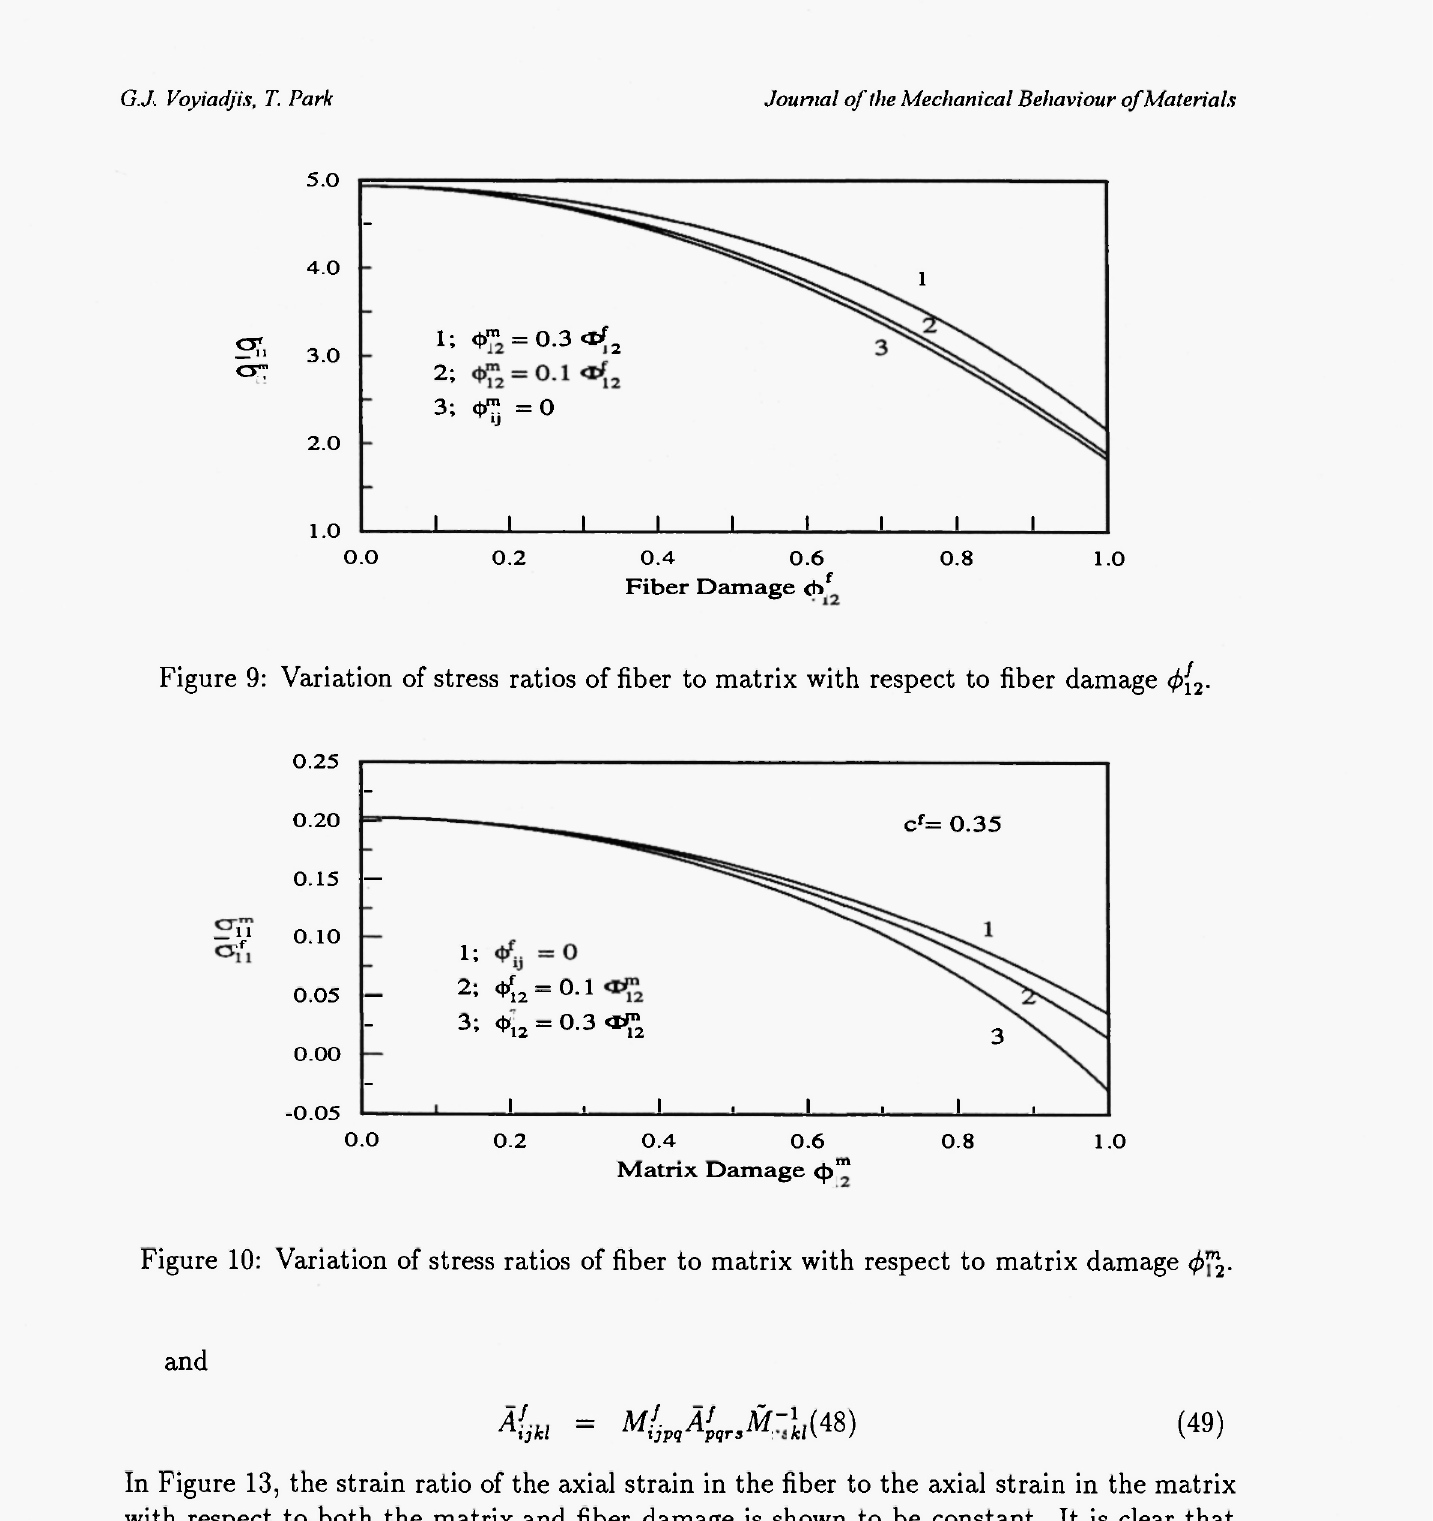
Figure 10: Variation of stress ratios of fiber to matrix with respect to matrix damage φ™